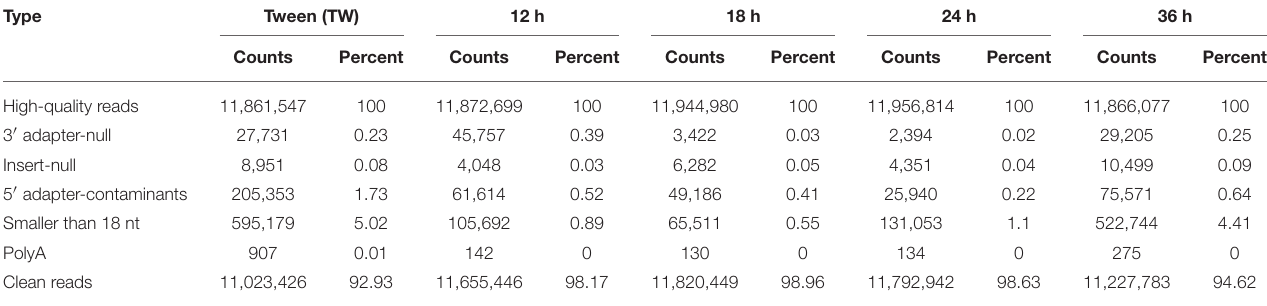
TABLE 1 | The classification of total small RNAs of the Plutella xylostella by sequencing.